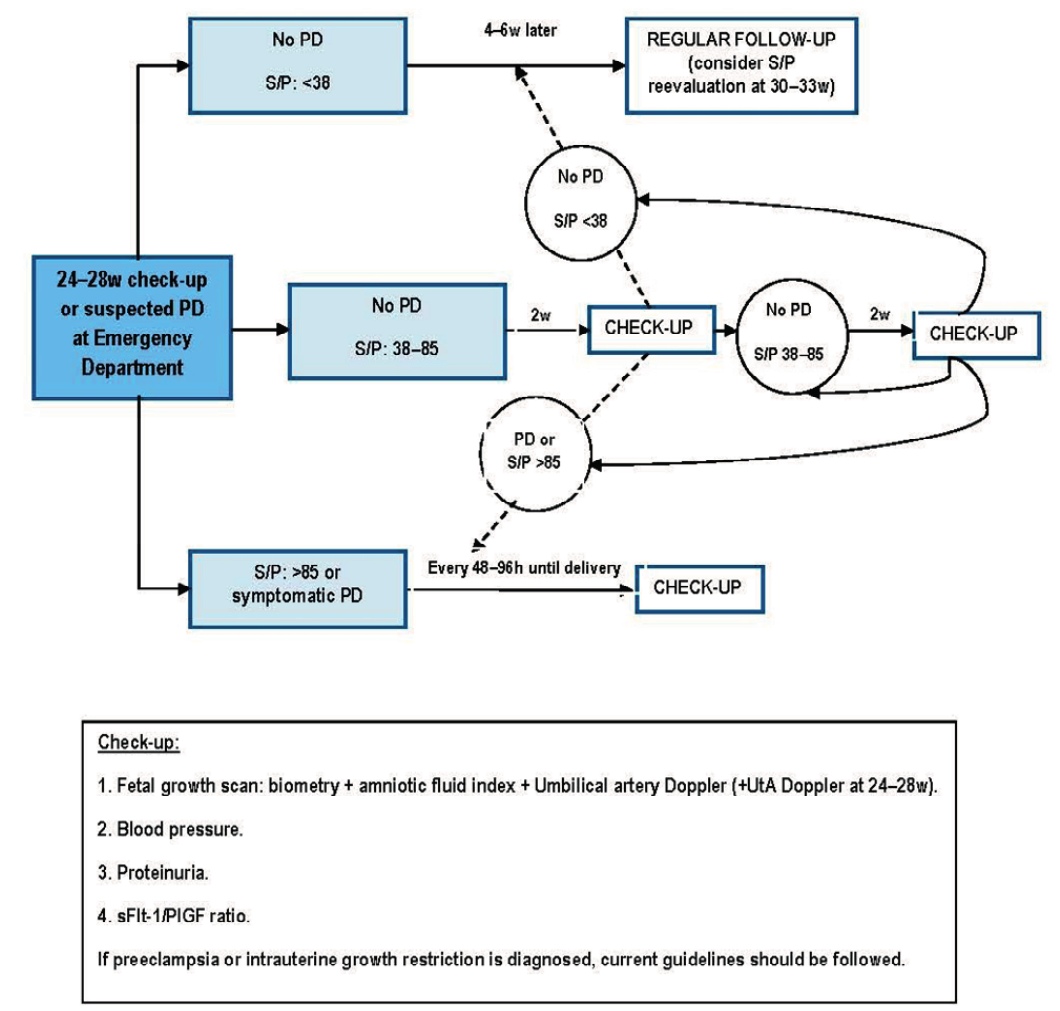
Figure 3. Algorithm for the intensive following-up of patients at risk of developing placental dysfunction-related disorders, including the implementation of angiogenesis-related biomarkers. PD, placental dysfunction; S/P, sFlt-1/PlGF ratio; UtA, uterine arteries; w, weeks of